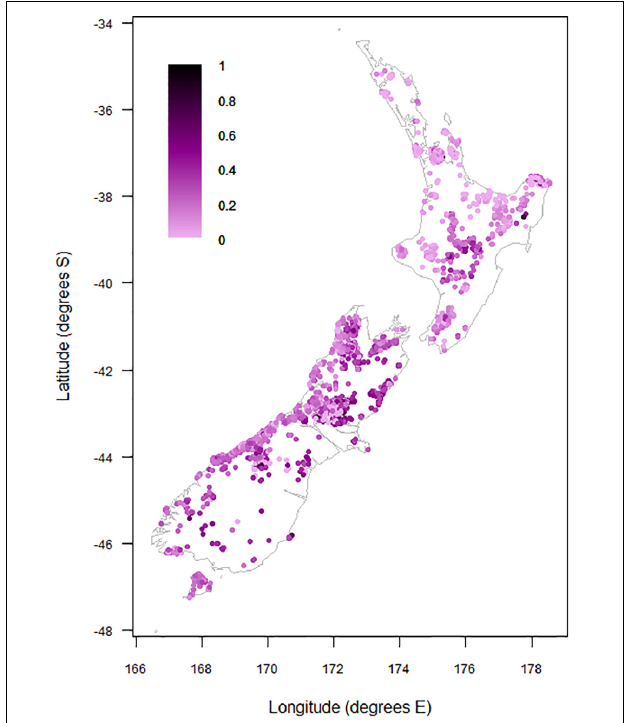
FIGURE 4 | Proportional contribution of divaricate species to arborescent assemblages on 9,601 relevé forest plots on the main islands of New Zealand.